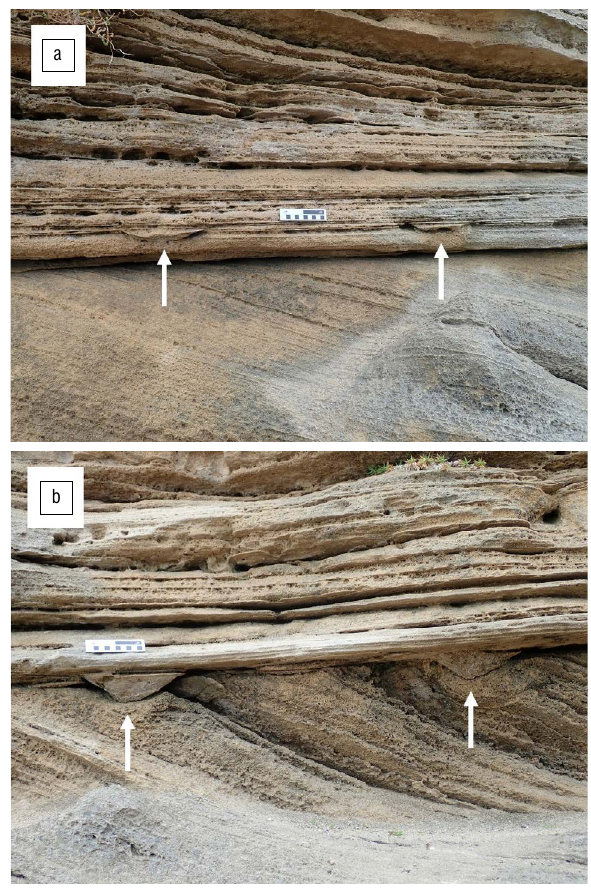
Figure 10: (a) The western tracks at Site 4, indicated by arrows, are in lower relief; scale bar = 10 cm. (b) The eastern tracks at Site 4, indicated by arrows, are deeper; scale bar = 10